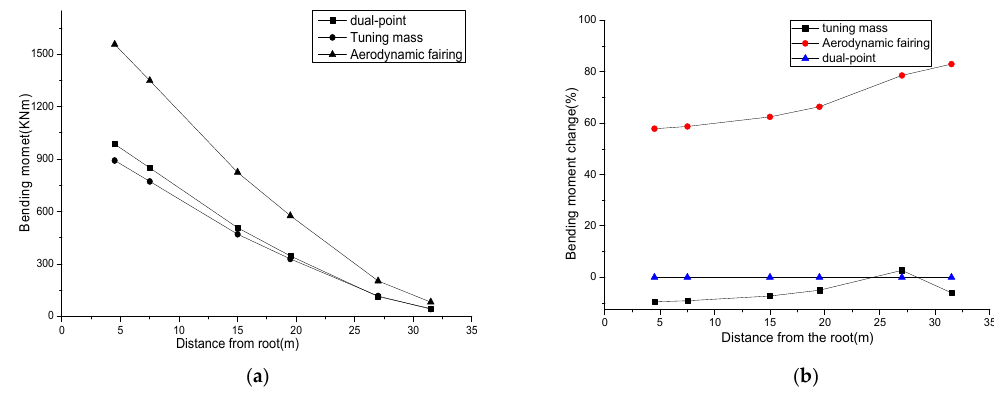
Figure 3. Bending moment distribution for different methods. ( a ) Bending moment distribution for different methods; ( b ) The change of moment distribution for different methods.